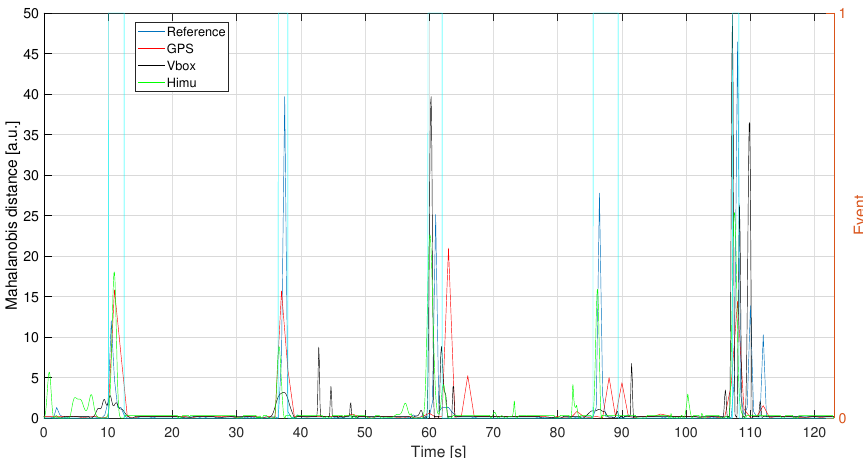
Figure 14. C1—Mahalanobis distances for Reference, GPS, VBOX and HIMU acceleration signals. Events are reported as pulsed train (light blue solid